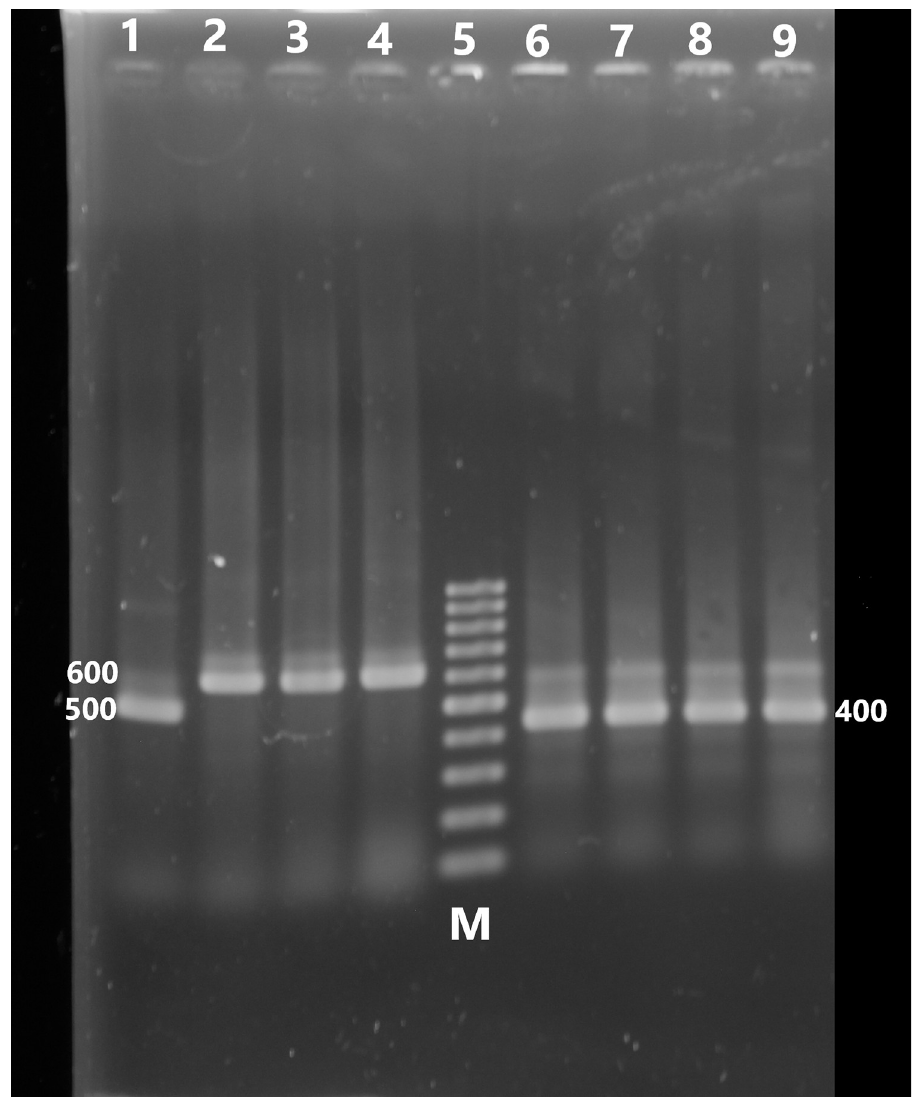
Fig 7. Agarose gel 1.5% stained with ethidium bromide showing the PCR products of 8 positive samples amplifying ITS region of Vahlkampfiidae using ITS1-2 primers showing a single band of 600 bp. ( Vahlkampfia ) in lanes (2,3,4), a single band of 500 bp. ( Allovahlkampfia ) in lane (1) and a single band of 400 bp. ( Naegleria ) lanes (6, 7, 8, 9). Lane 5; (M) marker = 100 bp DNA